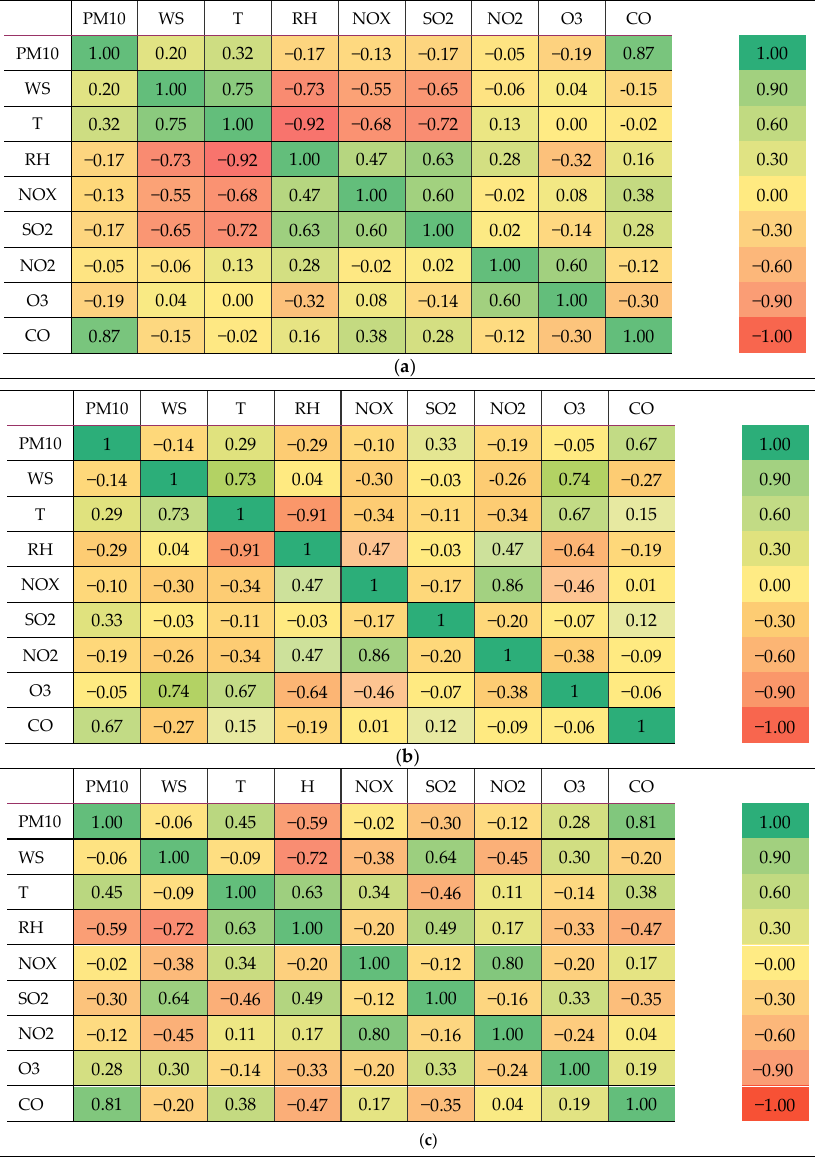
Figure 6. Heat map of the Pearson correlation matrix of PM10 levels with the other air pollutants and weather parameters for ( a ) Petaling Jaya, ( b ) Melaka, and ( c ) Pasir Gudang. For prediction model proposes, the parameters that were moderately to strongly cor- related (r >0.3) were used to develop the modified quantile regression model (Pearson – QR). Table 6 summarizes the parameters for each area. Table 6. Selected parameters for modified QR (Pearson – QR) model. Area Selected Parameter Petaling Jaya